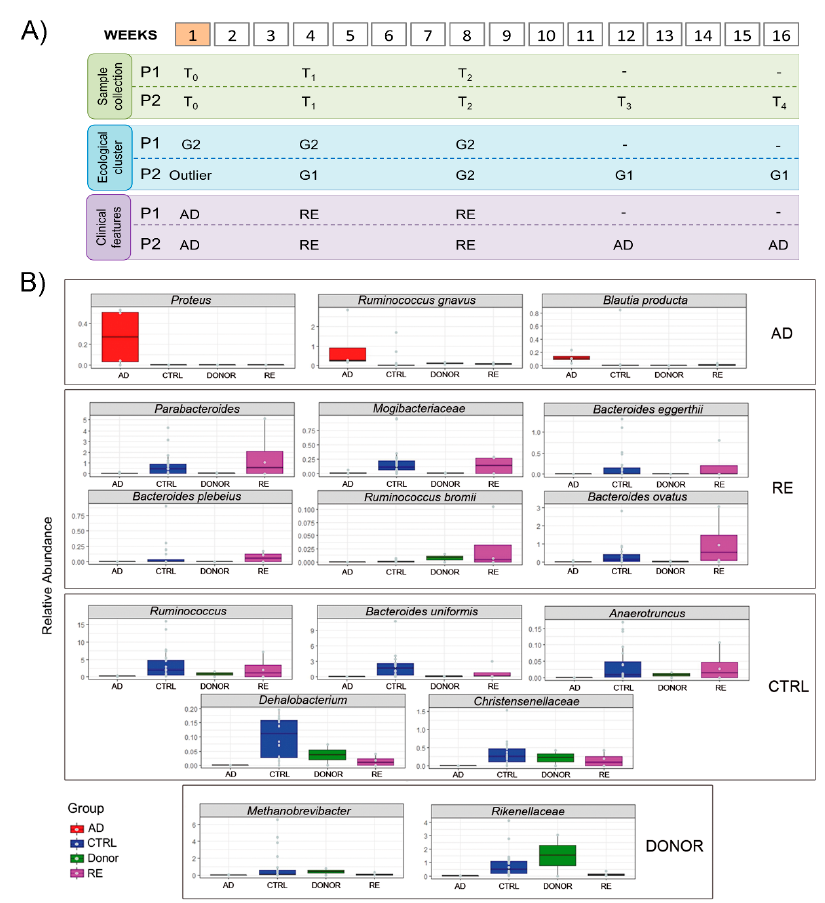
Figure 3. Experimental timeline and sample clusterization, based on ecological and clinical evaluations. Panel A. Samples collection: for both patients, sample collection timeline is expressed in weeks after FMT (orange box). Ecological cluster: hierarchical cluster analysis, based on microbiota